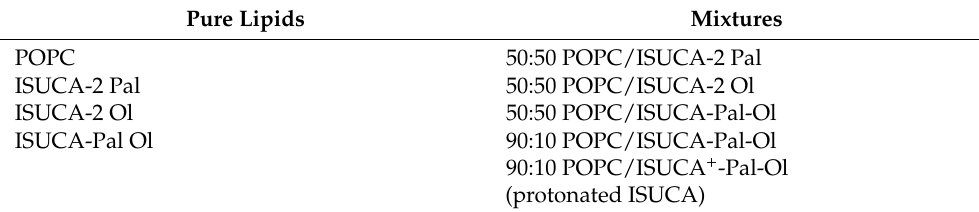
Table 3. Composition of the bilayers studied by